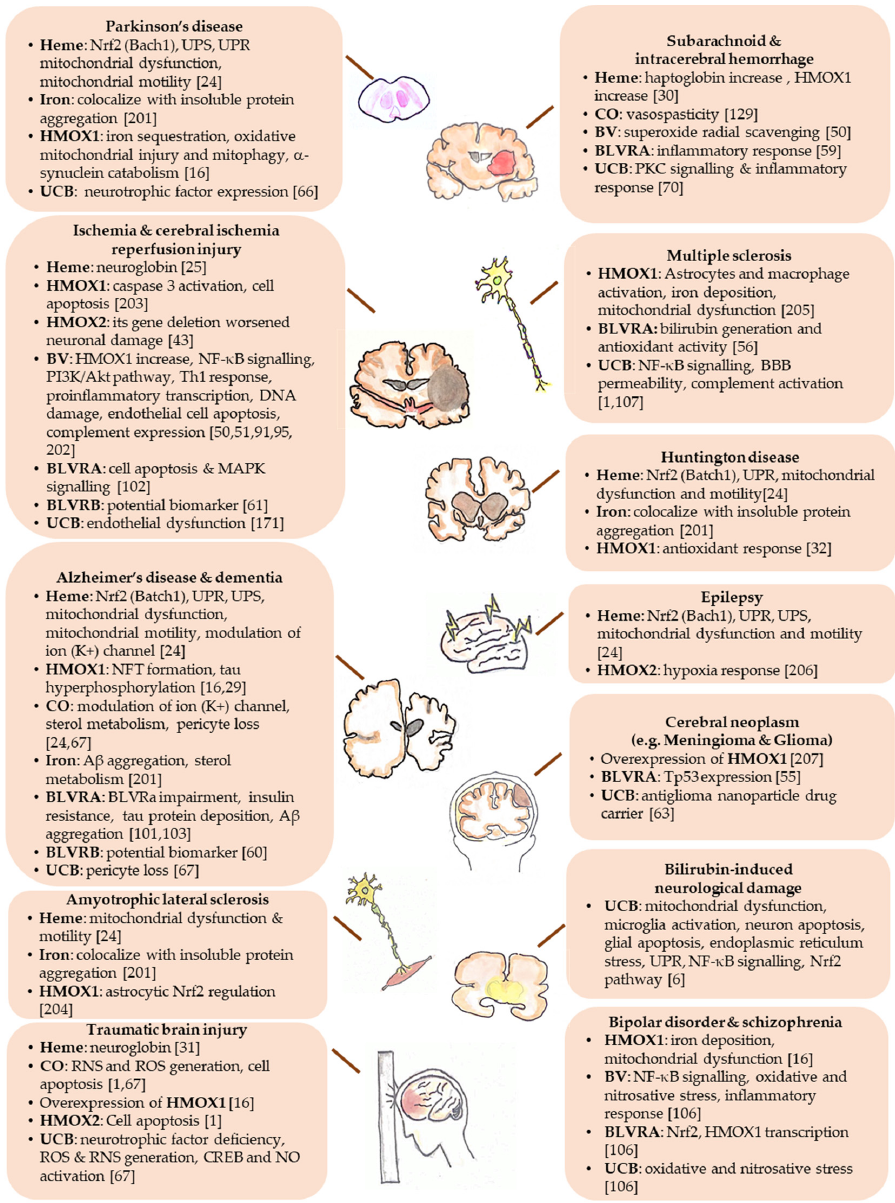
Figure 2. The known and the putative molecular targets of the YPs on the CNS diseases.